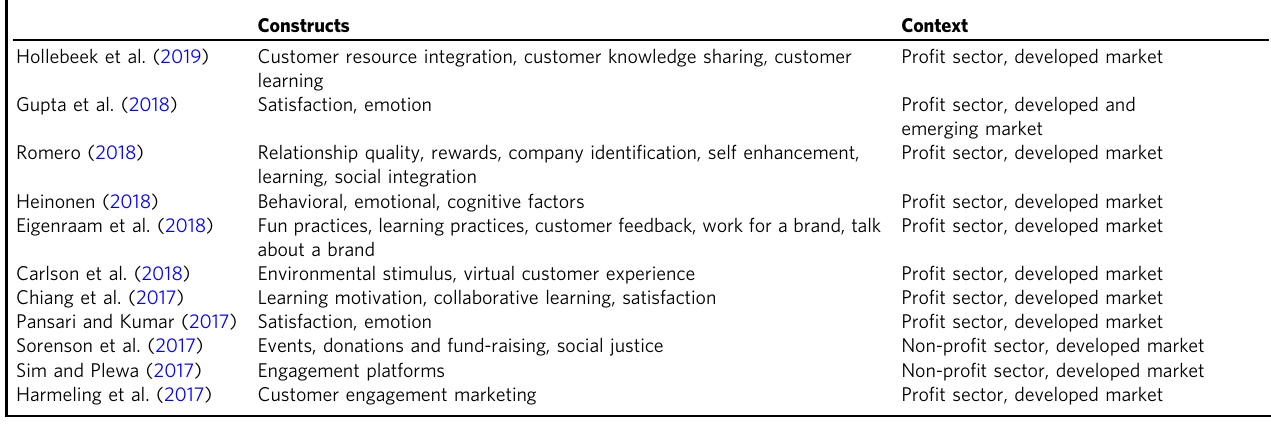
Table 1 User engagement and communication content studies and context.